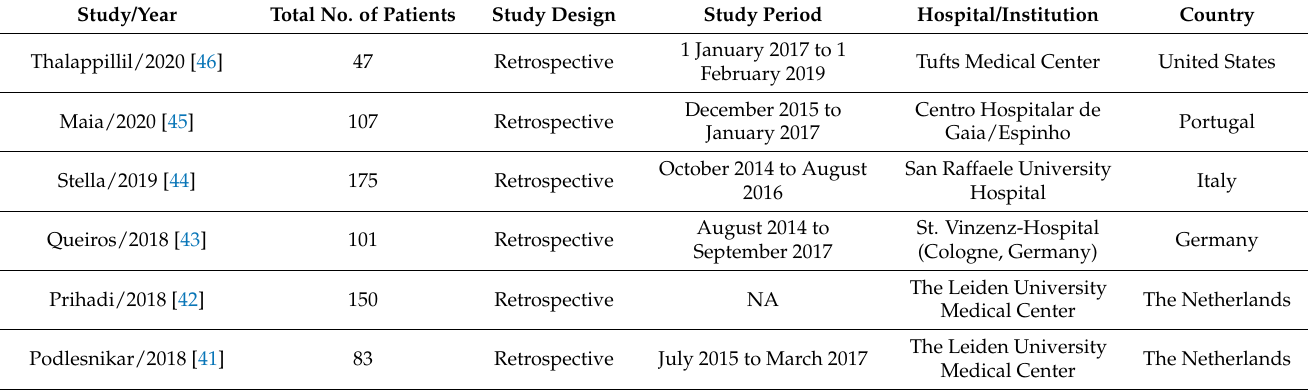
Table 1. Study characteristics of included